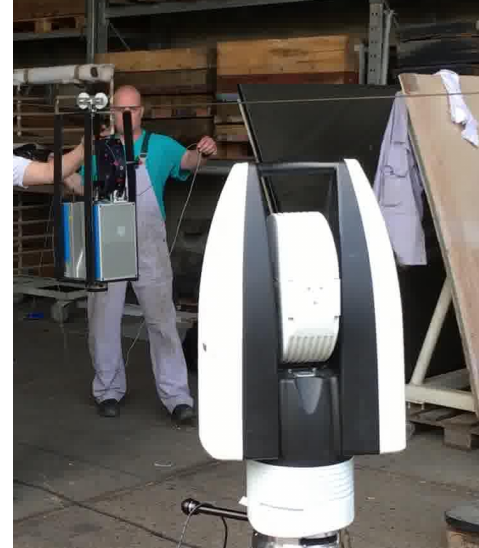
Figure 2. The k-TLS based MSS mounted on the wire rope guided construction.